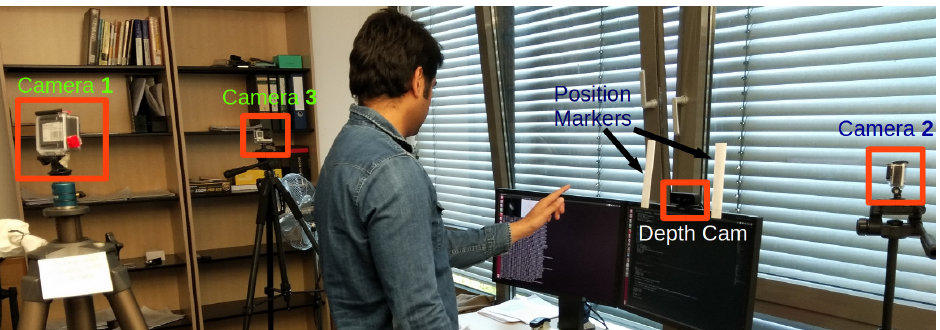
Figure 2. Our setup for in-air signature acquisition. The depth camera is mounted on top of the screen. The position markers on both sides of the depth camera allow capturing of in-air signature within the field of view (FoV) of the camera. Three GoPro cameras are placed around a user to record the hand motion in 3D space from different view points. Camera 3 specifically records the depth